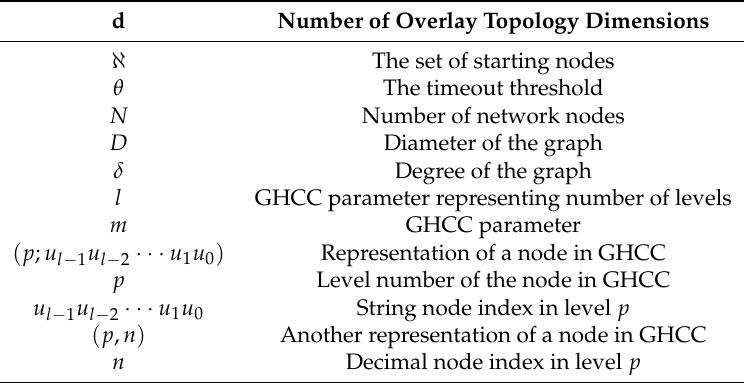
Table 1. Table of